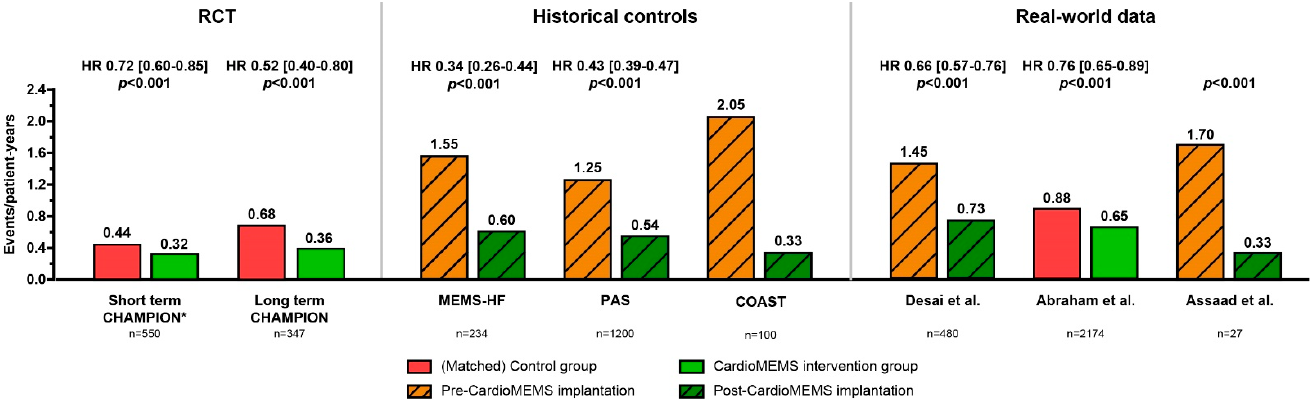
Figure 10. Overview of the clinical efficacy in reducing HF hospitalizations by the CardioMEMS HF system as reported in clinical studies. Legend: red and orange bars indicate either control group or the historical controls; green bars indicate the active CardioMEMS patient group; * Indicates event rate per patient per 6 months. An overview of the study characteristics and their results is shown in Table 1. Table 1. Overview of study characteristics and patient baseline variables of CardioMEMS studies.